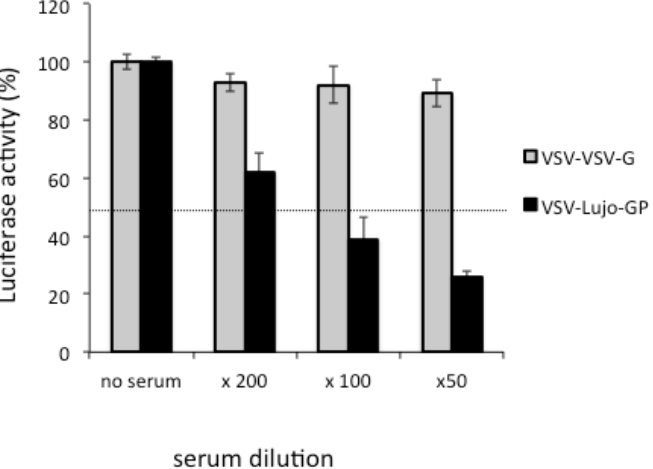
Figure 3. Neutralization assay for VSV-Lujo-GP. VSV-Lujo-GP or a control pseudotype (VSV-VSV-G) that expressed luciferase was incubated with serially diluted serum obtained from a rabbit immunized with Lujo-GPC, and was then inoculated in triplicate into Vero E6 cells. The luciferase activity (%) of each well compared to the negative control (no serum) is